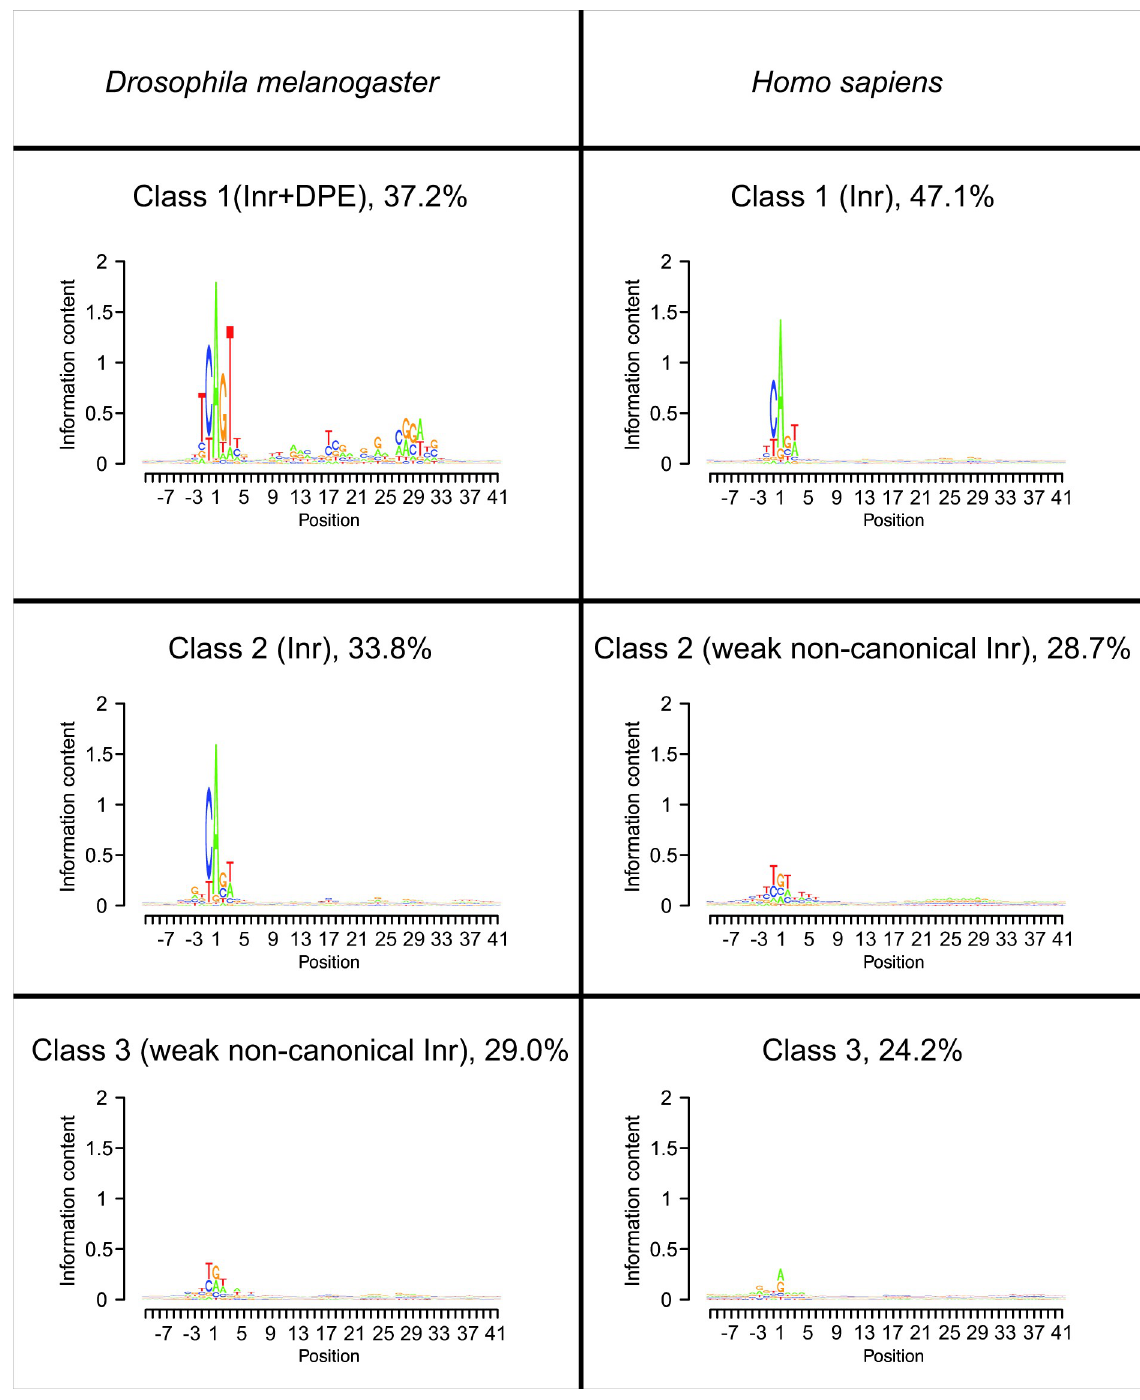
Fig 2. Partitioning of promoter sequences using the basic probabilistic partitioning EM algorithm. Three major classes with distinct core promoter compositions were identified within Drosophila melanogaster and human promoters. For each class, its frequency among the examined promoters is indicated. Numerical data are provided in S2